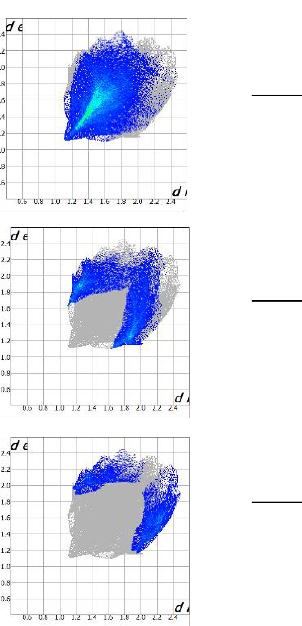
Figure 12. Present the packing stabilized by C–H · · · O and the C–H · · · π . Interactions that are confirmed by Hirshfeld surface shape index ( I ) showing the edge-to-face C–H · · · π interactions and the Hirshfeld surface dnorm map ( II ) showing C–H · · · O interactions for BBP.